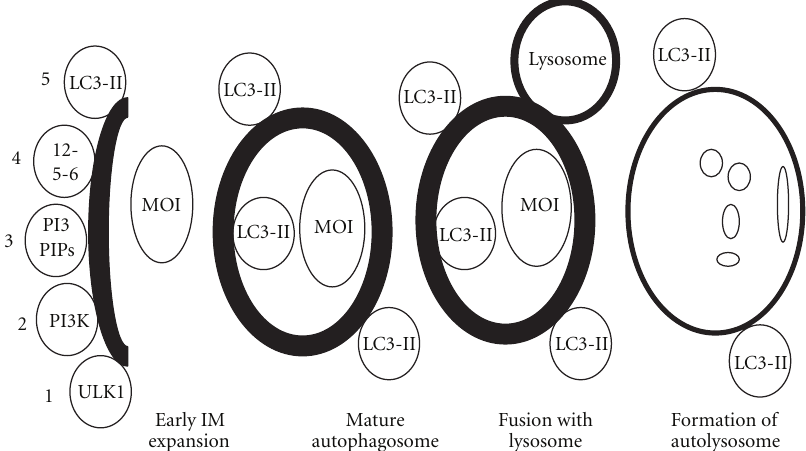
Figure 5: Macroautophagy. Recruitment of the large ULK1 complex to the omegasome (1) induces the migration of the class-III PI3K kinase complex to the same site (2). PI(3)PIP recruitment (3) promotes the localization of ATG12-ATG5-ATG16L (4) and LC3-II (5). The fully formed autophagosome engulfs the MOI and fuses with a lysosome, forming an autolysosome, where lysosomal hydrolases contained within the lysosome degrade the MOI. MOI: material of interest; 12-5-6: ATG12-ATG5-ATG16L; PI3P1P: phosphatidylinositol triphosphate- interacting protein; PSE: phospholipid synthesizing enzyme; LC3: microtubule-associated light chain 3; PI3K: phophoinositide 3 kinase; ULK1: unc-51-like kinase 1; ER: endoplasmic reticulum; IM: isolation